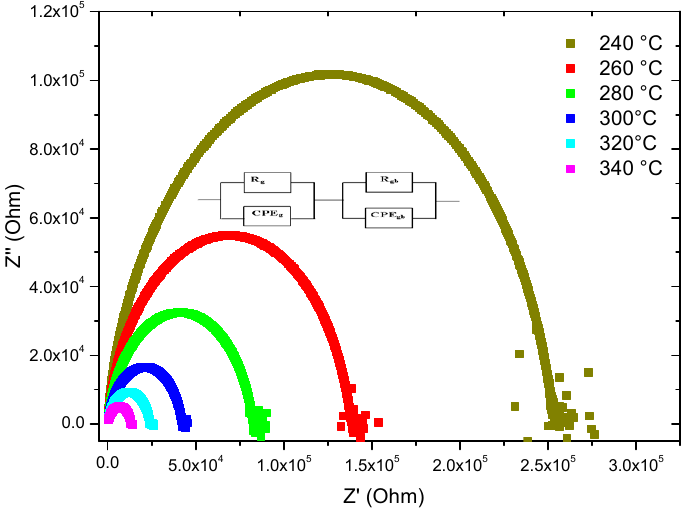
Figure 6. Experimental and theoretical impedance diagrams of the sample TZV5 at the temperature T = 280 °C.